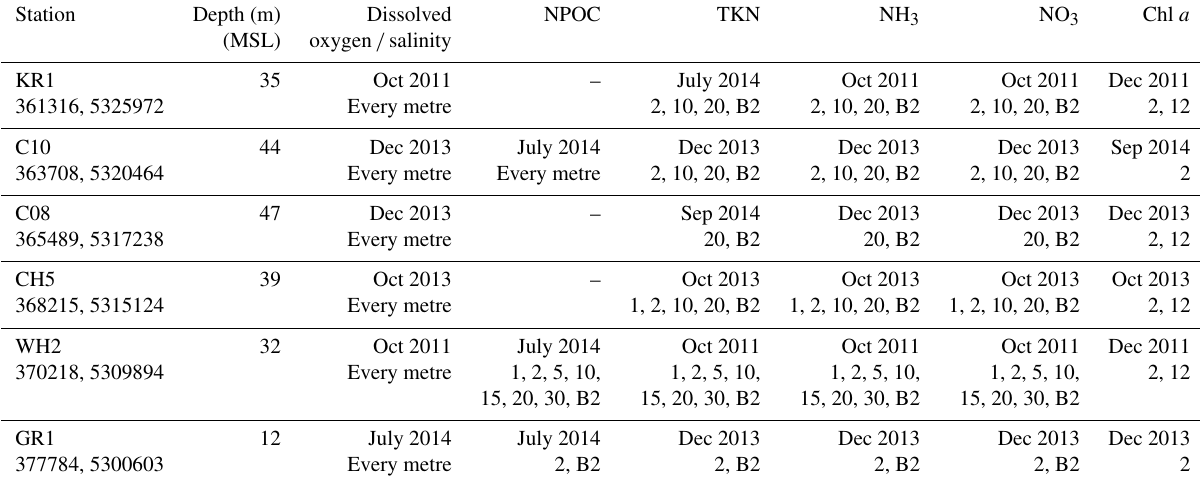
Station coordinates given in UTM (Zone 55G). Dates indicate starting month of sampling parameter. Sampling depths indicated under each date, with B2 = 2m from